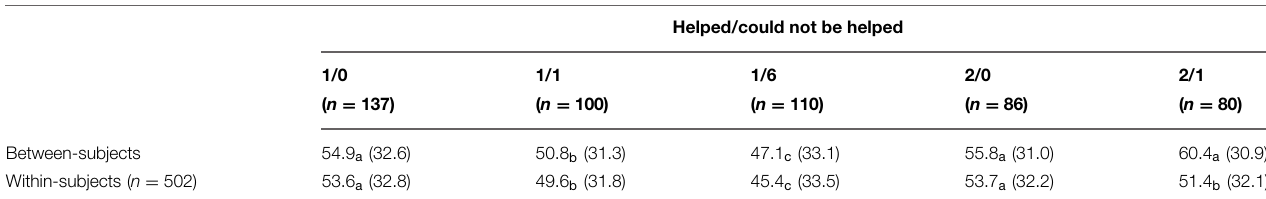
TABLE 3 | Mean and SD for warm-glow ratings for both between- and within-subject comparisons (Study